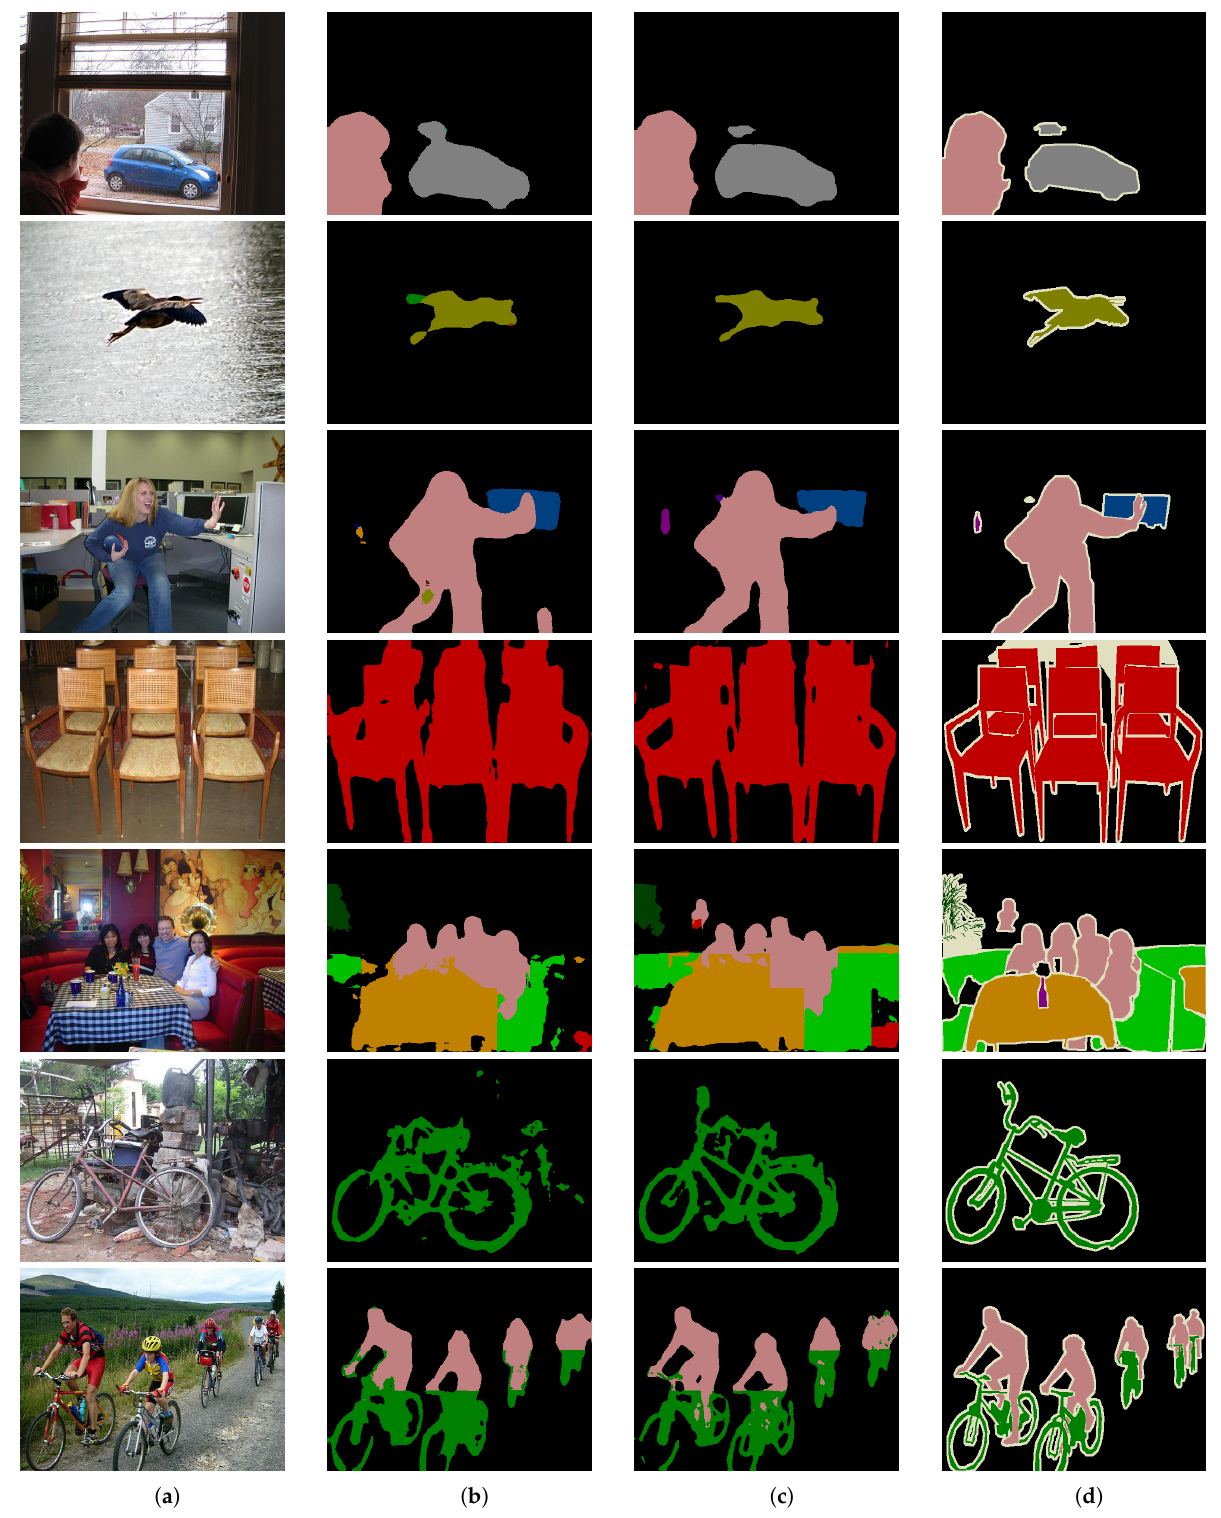
Figure 6. Examples of the output before and after adding the bokeh module on the PASCAL VOC 2012 dataset, our resulting contour is much smoother. The first three rows are the results of experiments on FCN, and the last four rows are the results of experiments on Hyperseg. ( a ) Image; ( b ) (Re)Seg.Network; ( c ) (Re)Seg.Network+bokeh; ( d ) Ground